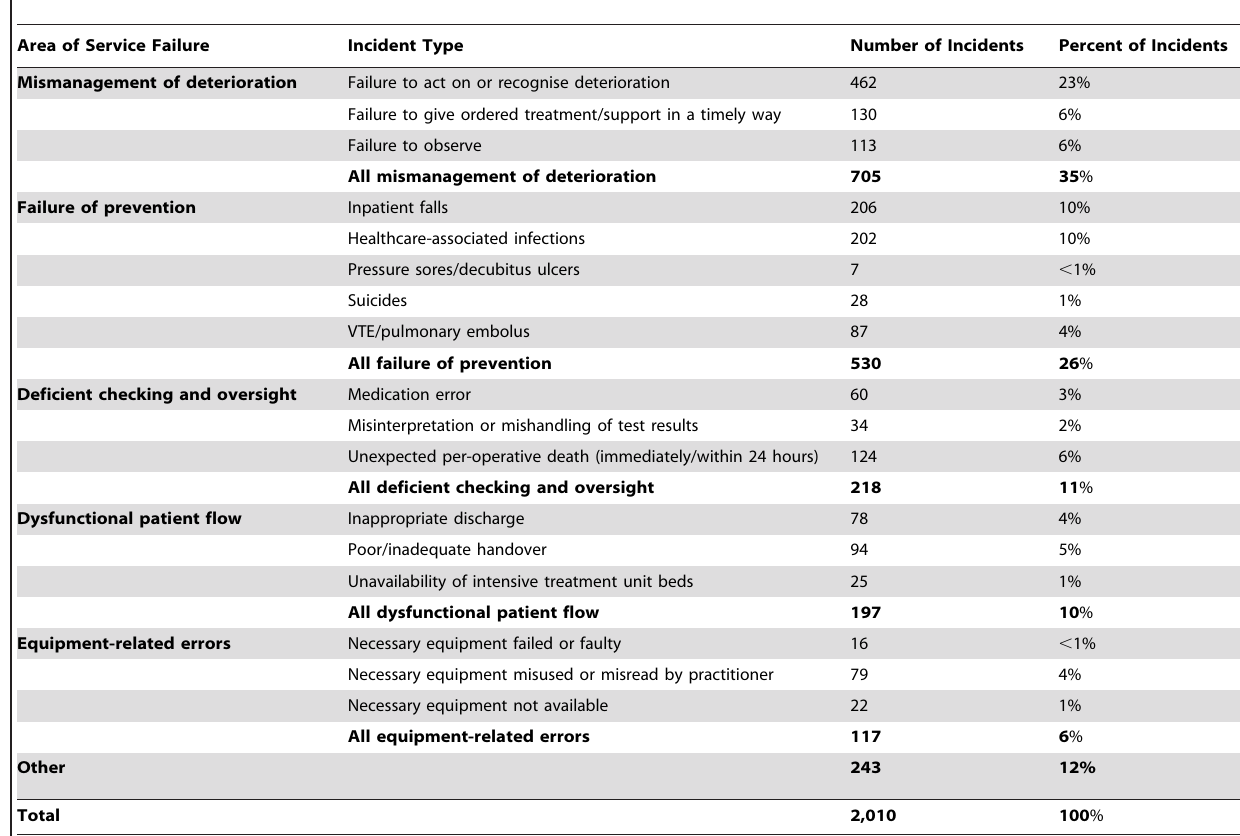
Table 1. Patient-safety-related adult deaths in NHS acute hospital settings: analysis of areas of systemic service failure.